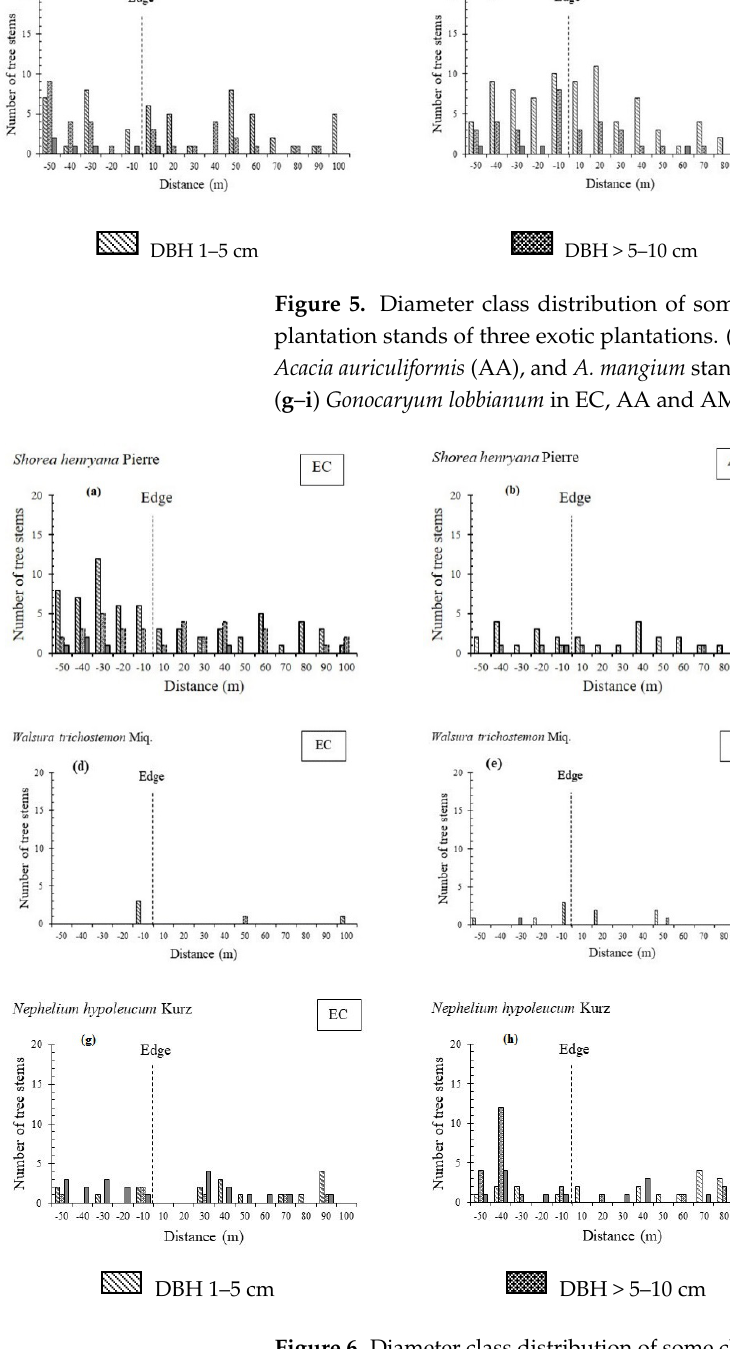
Figure 6. Diameter class distribution of some climax tree species along the forest remnants planta- tion stands of three exotic plantations. ( a – c ) Shorea henryana in Eucalyptus camaldulensis (EC), Acacia auriculiformis (AA), and A. mangium stands, ( d – f ) Walsura trichostemon in EC, AA and AM stands, ( g – i ) Nephelium hypoleucum in EC, AA and AM stands.